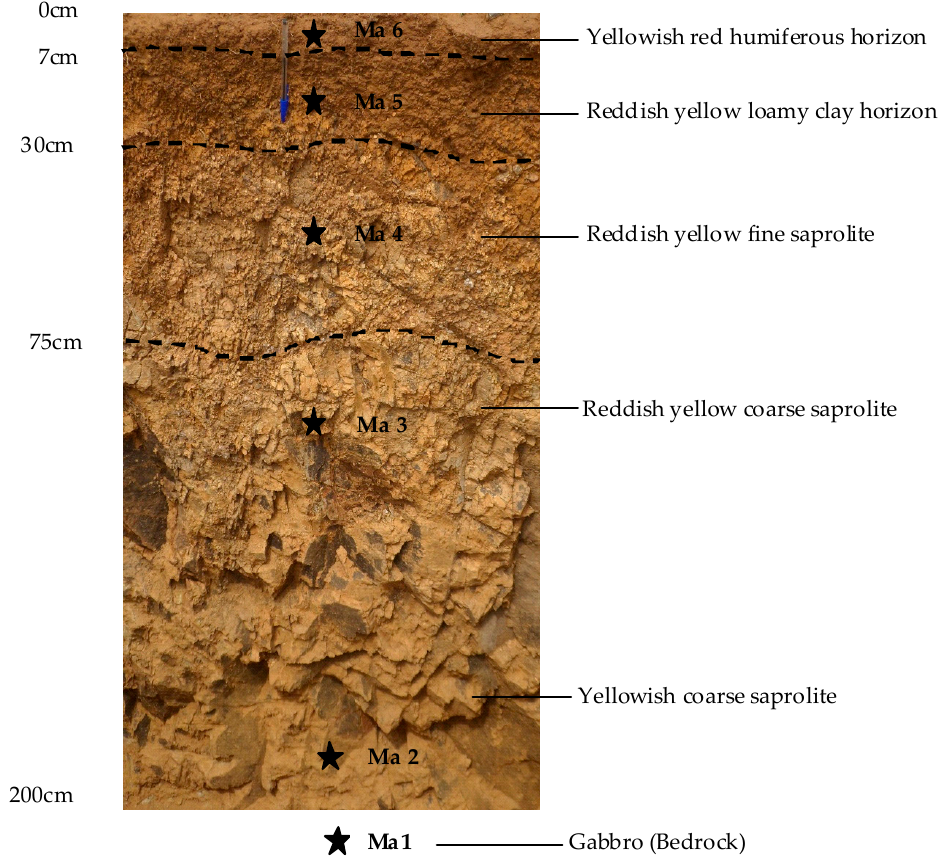
Figure 2. Morphological characteristics of the soil profile studied in the Maroua region (Cameroon). (Stars are sampling points; discontinuous lines are boundaries between horizons.)